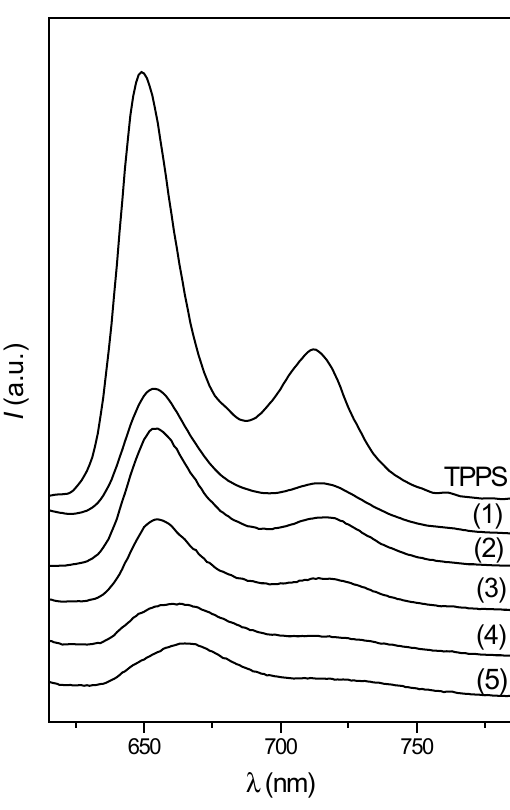
Figure 3. Emission spectra of meso-tetrakis(4-sulfonatophenyl)por- phine in formamide solution (TPPS) and in the formamide dispersions with LDH3 (1-5).